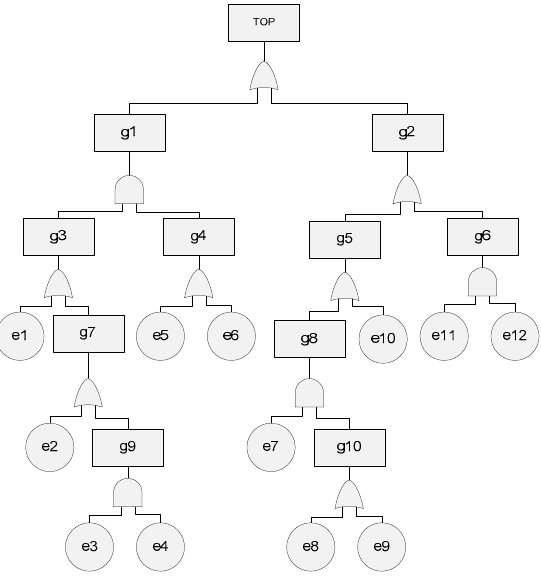
Figure 7. Fault Tree example.